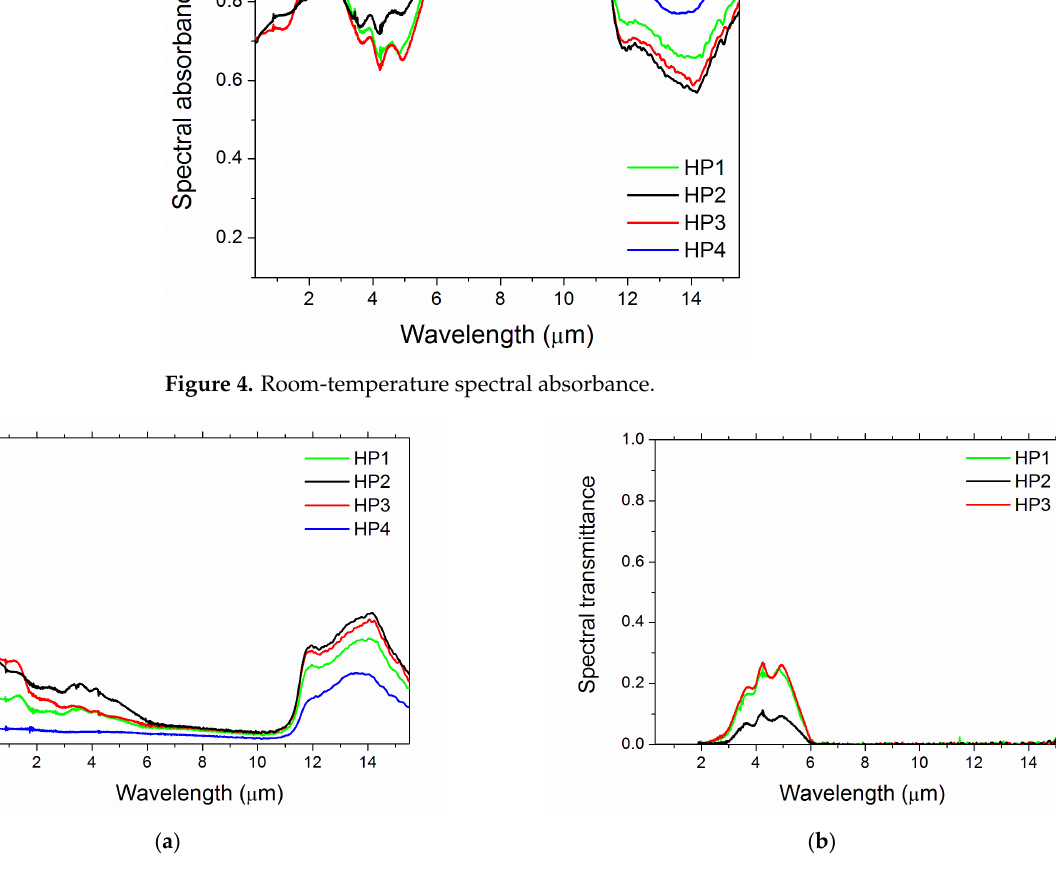
Figure 5. Room-temperature spectral hemispherical reflectance ( a ) and spectral hemispherical transmittance ( b ). Sample HP4 shows a null transmittance in the whole investigated range, thus it does not appear in the plot.